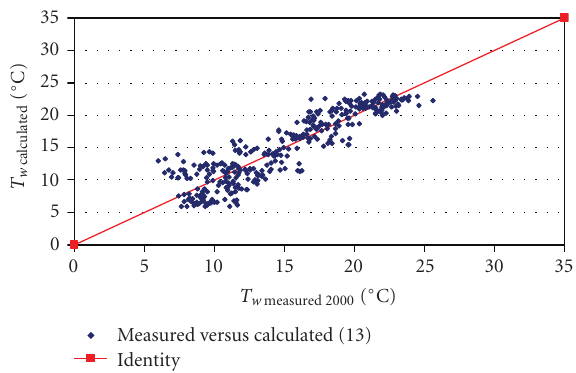
Figure 12: Water temperature values and residuals, experiment without standardization (weekly average values).